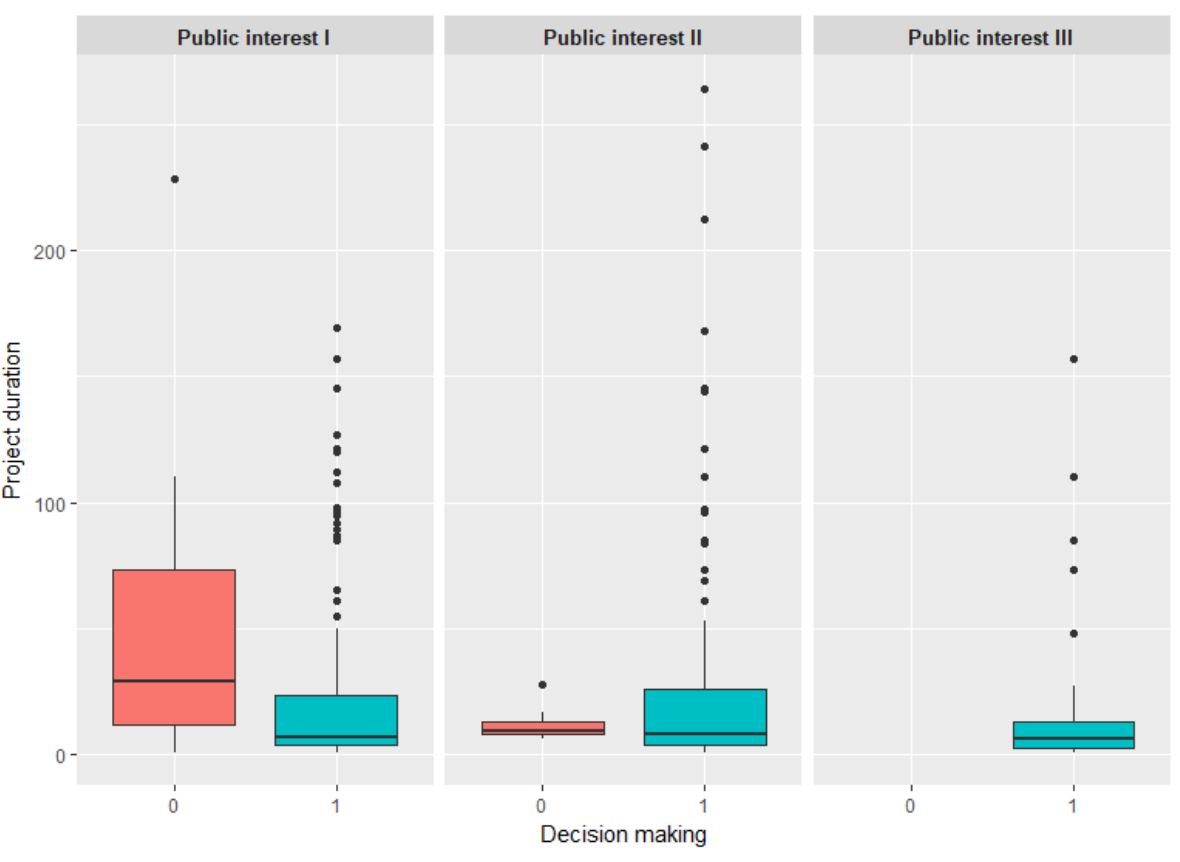
Figure 2. The interaction of variables DM and PA (by the first author).